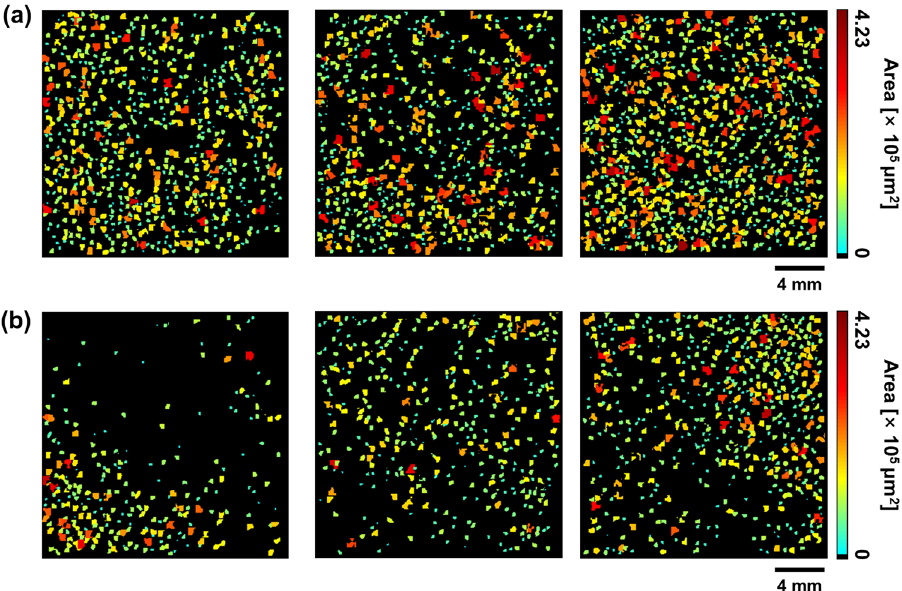
Figure 7. The area map of ( a ) the SHDI and ( b ) SLDI at difference depth. From the left, the area map from the depth above the depth of focus (1/4 depth), in the depth of focus (2/4 depth), and the depth below the depth of focus (3/4 depth). (plotted by: MATLAB R2018a—https:// www. mathw orks. com/ produ cts/ matlab.